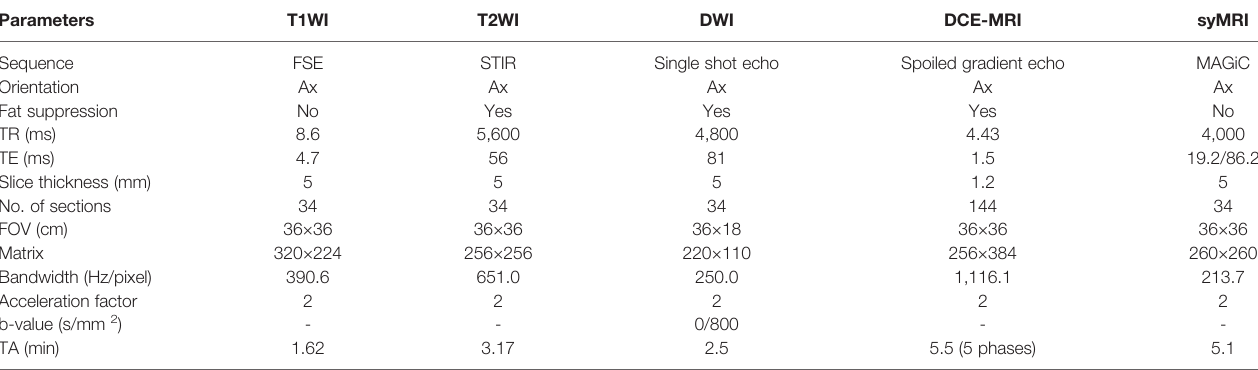
TABLE 1 | Scan parameters for all